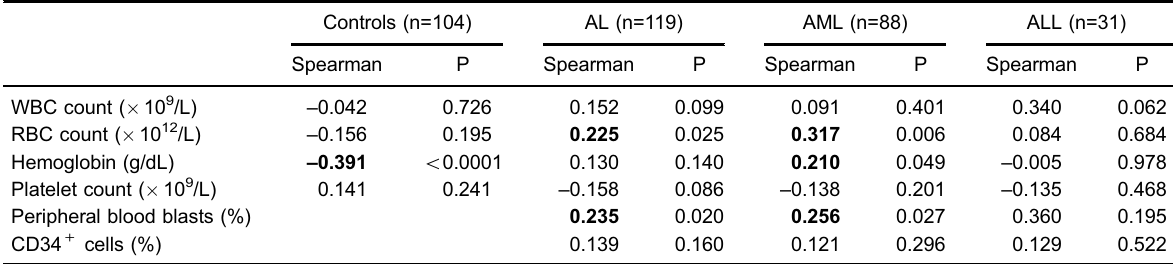
Table 2. Spearman correlations of FAMLF-CS with hematological parameters. Controls (n=104) AL (n=119) AML (n=88) Spearman